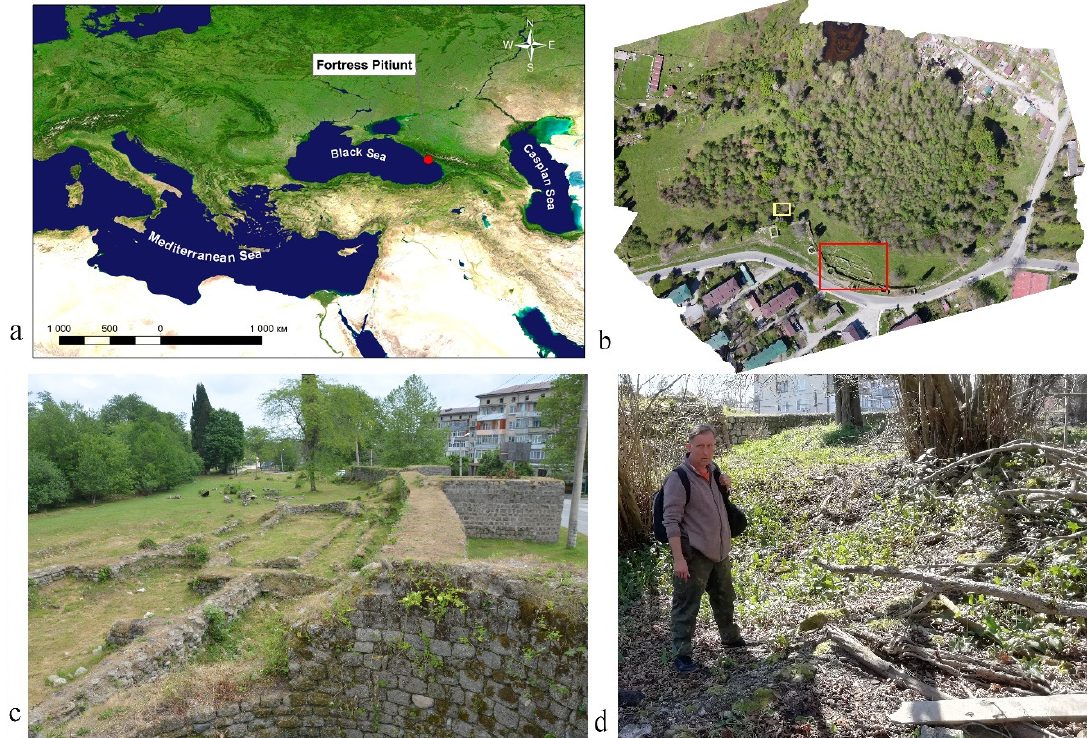
Figure 1. The Roman fortress Pitiunt: ( a ) localization of the site; ( b ) view of the site from a drone (a red rectangle marks the view c of the ruins of the temples; the yellow rectangle marks the view d of the wall we have exposed); ( c ) view of the ruins of the temples from the west; ( d ) Dr. A. Kizilov stands on a fragment of a stone wall discovered by our expedition, which was not previously marked on the existing plans of the castle.